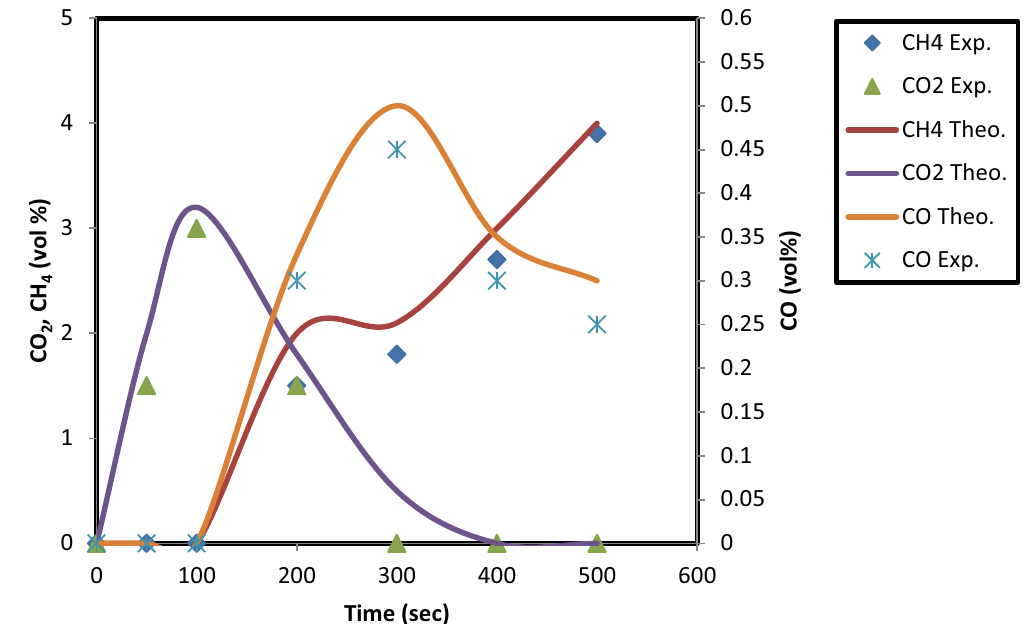
Fig. 2 Comparison between experimental and theoretical species for reduction (fuel) reactor at the quasi-equilibrium